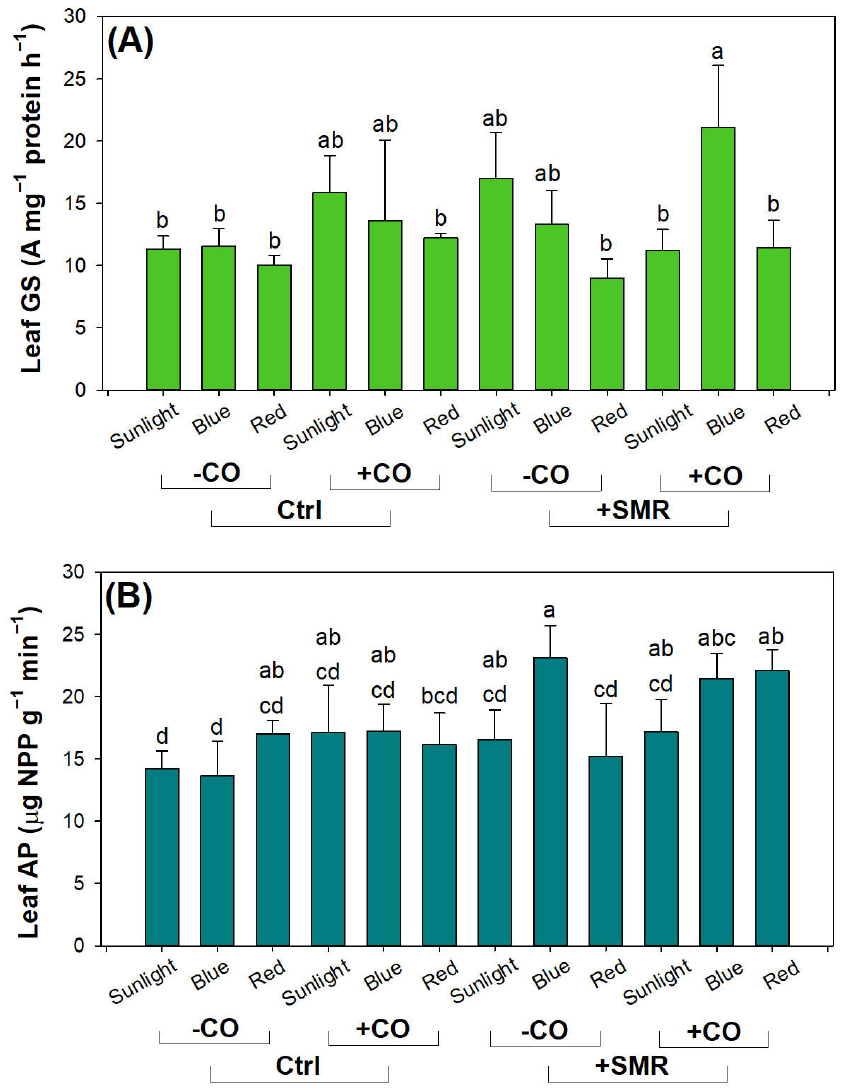
Figure 6. Leaf glutamine synthetase (GS) and acid phosphate (AP) activities in black chokeberry ( Aronia melanocarpa (Michx.) Elliott 1821) exposed to combined light-type (sunlight, blue light-emitting diode (LED), red LED), chitosan oligosaccharide (CO), and spent mushroom residue (SMR) treatments: ( A ) combined light, SMR, and CO effects on GS activity; ( B ) combined light, SMR, and CO effects on AP activity. Different letters mark significant difference according to Tukey test at 0.05 level.